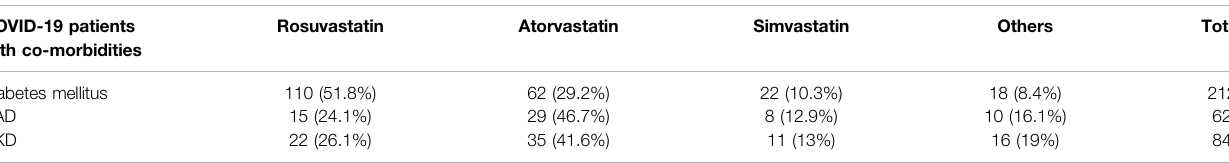
TABLE 7 | Preferred statin in a COVID-19 patient with